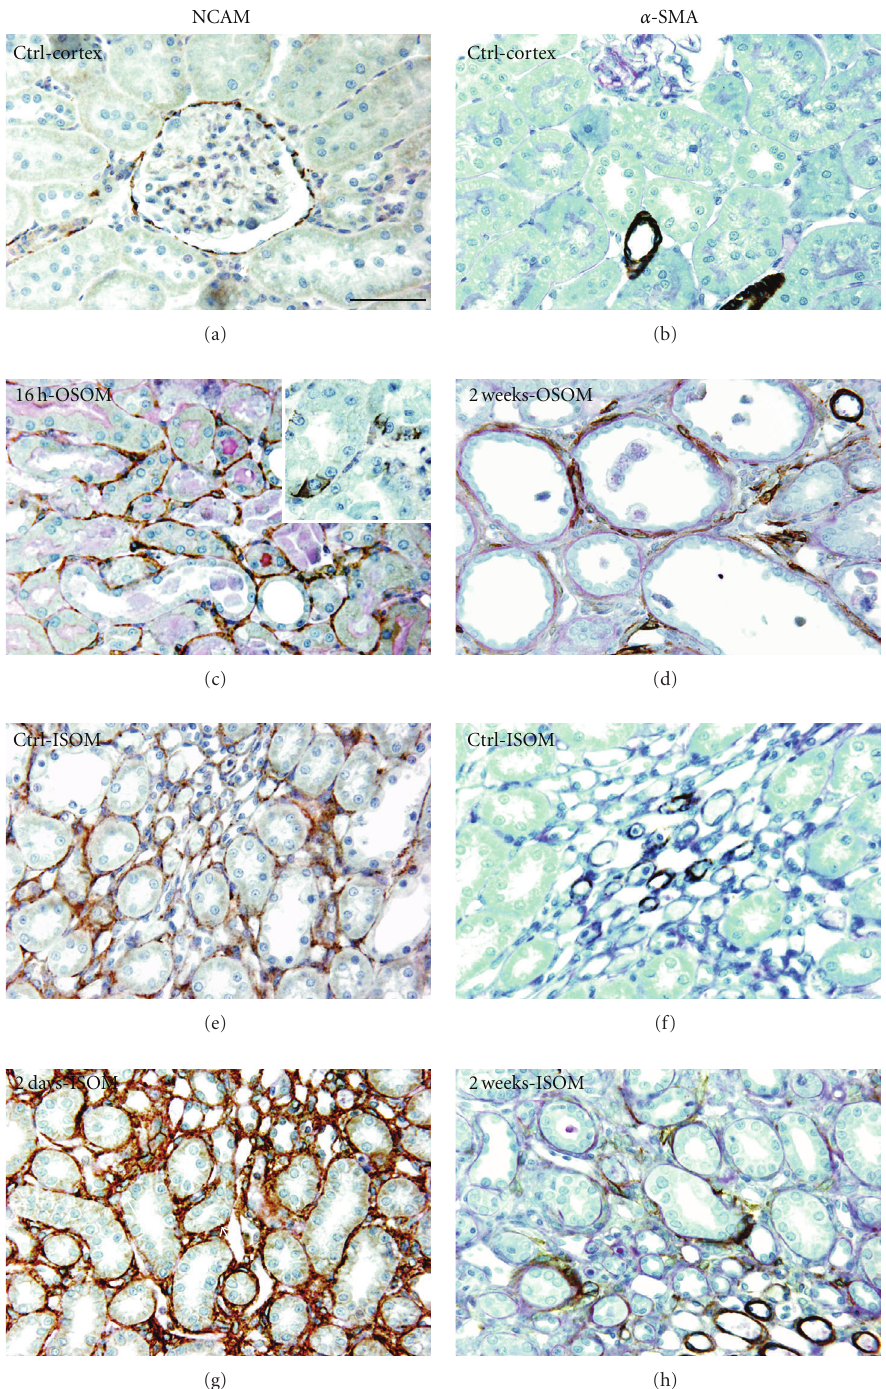
Figure 7: Distribution of NCAM-positive cells (left column) and of α -SMA-positive cells (right column) in the renal interstitium of control (a, b, e, f) or at di ff erent time intervals after ischemia-reperfusion (c, d, g, h). In control, NCAM-positive interstitial cells formed a loose network around cortical tubules (a) but with a higher density in ISOM (e). The density of positive cells in OSOM increased 16 hours after reperfusion mainly in the vicinity of altered tubules (c). Sometimes isolated epithelial cells appeared positive in altered tubules of OSOM (c inset). Within ISOM, the density of positive cells increased 12 hours after ischemia and remains high during the two following weeks (g). In control kidneys, the immunolabeling with an anti- α -SMA antibody was limited to the media of arteriolar vessels (b) and to pericytes of the ascending vasa recta in the vascular bundles of ISOM (f). Two weeks after reperfusion, α -SMA immunoreactivity is present in flattened cells surrounding precystic tubules (d) while ISOM remained similar to controls (h). Scale bar. 30 μ m: